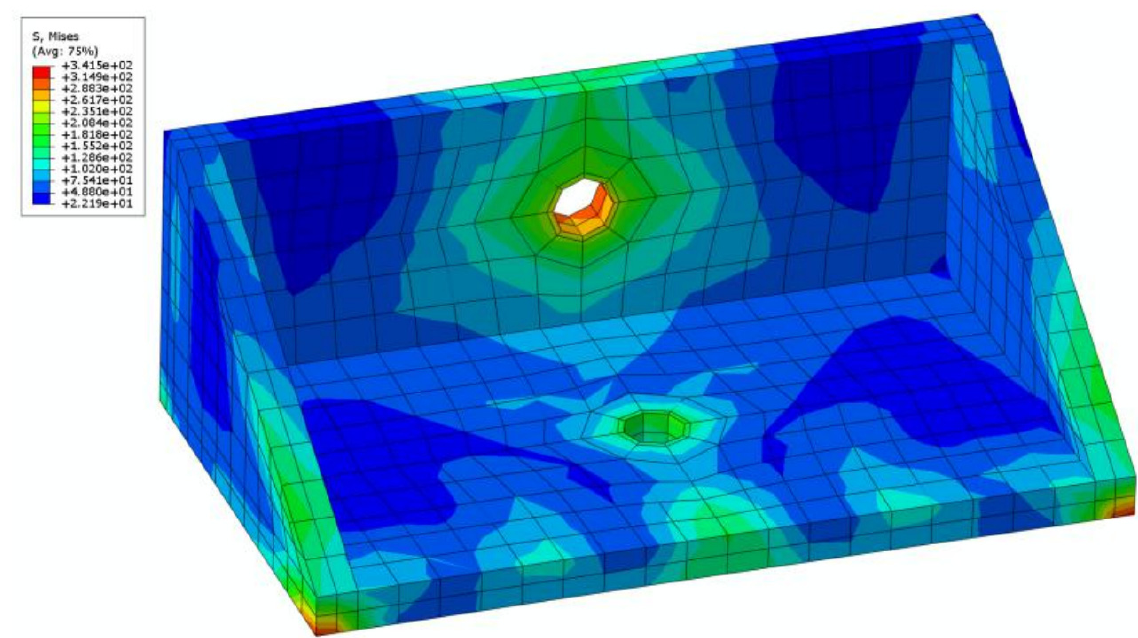
Figure 34. Angle stress cloud.